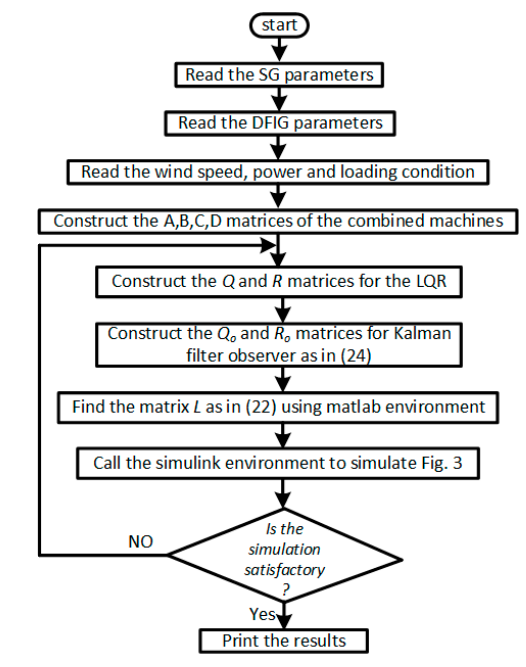
Figure 3. Numerical solution flow chart of the combined machines association via LQG approach